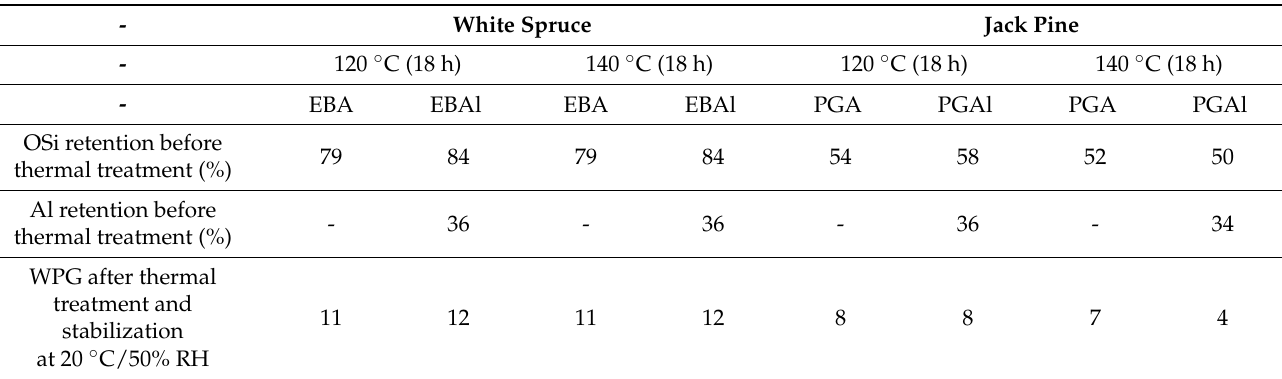
Table 5. Retention after impregnation and weight percent gain after thermal treatment for white spruce and jack pine (50 mm × 50 mm × 19 mm samples).